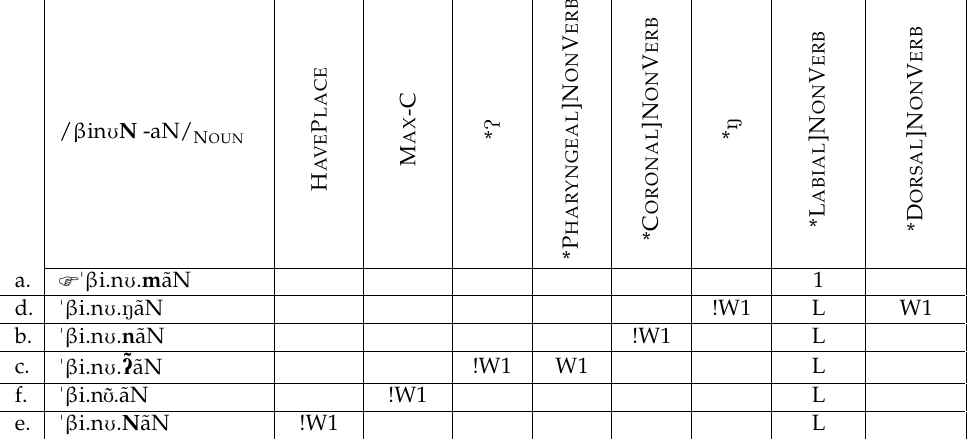
/kap ɨ C -aN/ N OUN